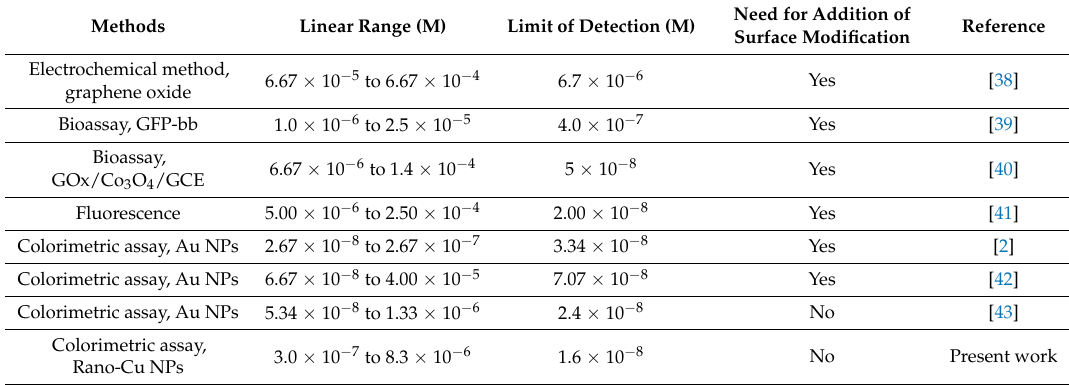
Table 1. Comparison of reported methods with ranolazine-functionalized Cu NP sensor for detection of As 3+